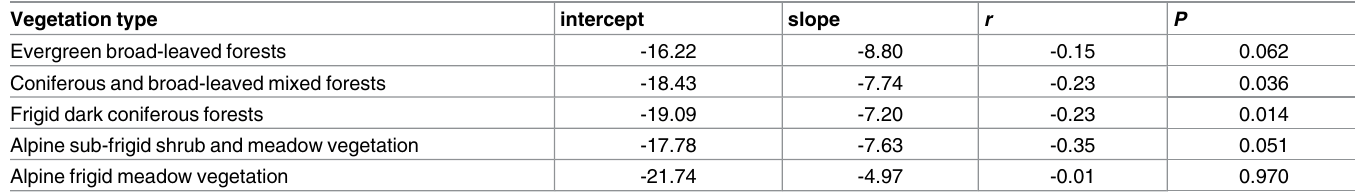
Table 2. Results of reduced major axis regressions of N mass vs. δ 13 C for different vegetation